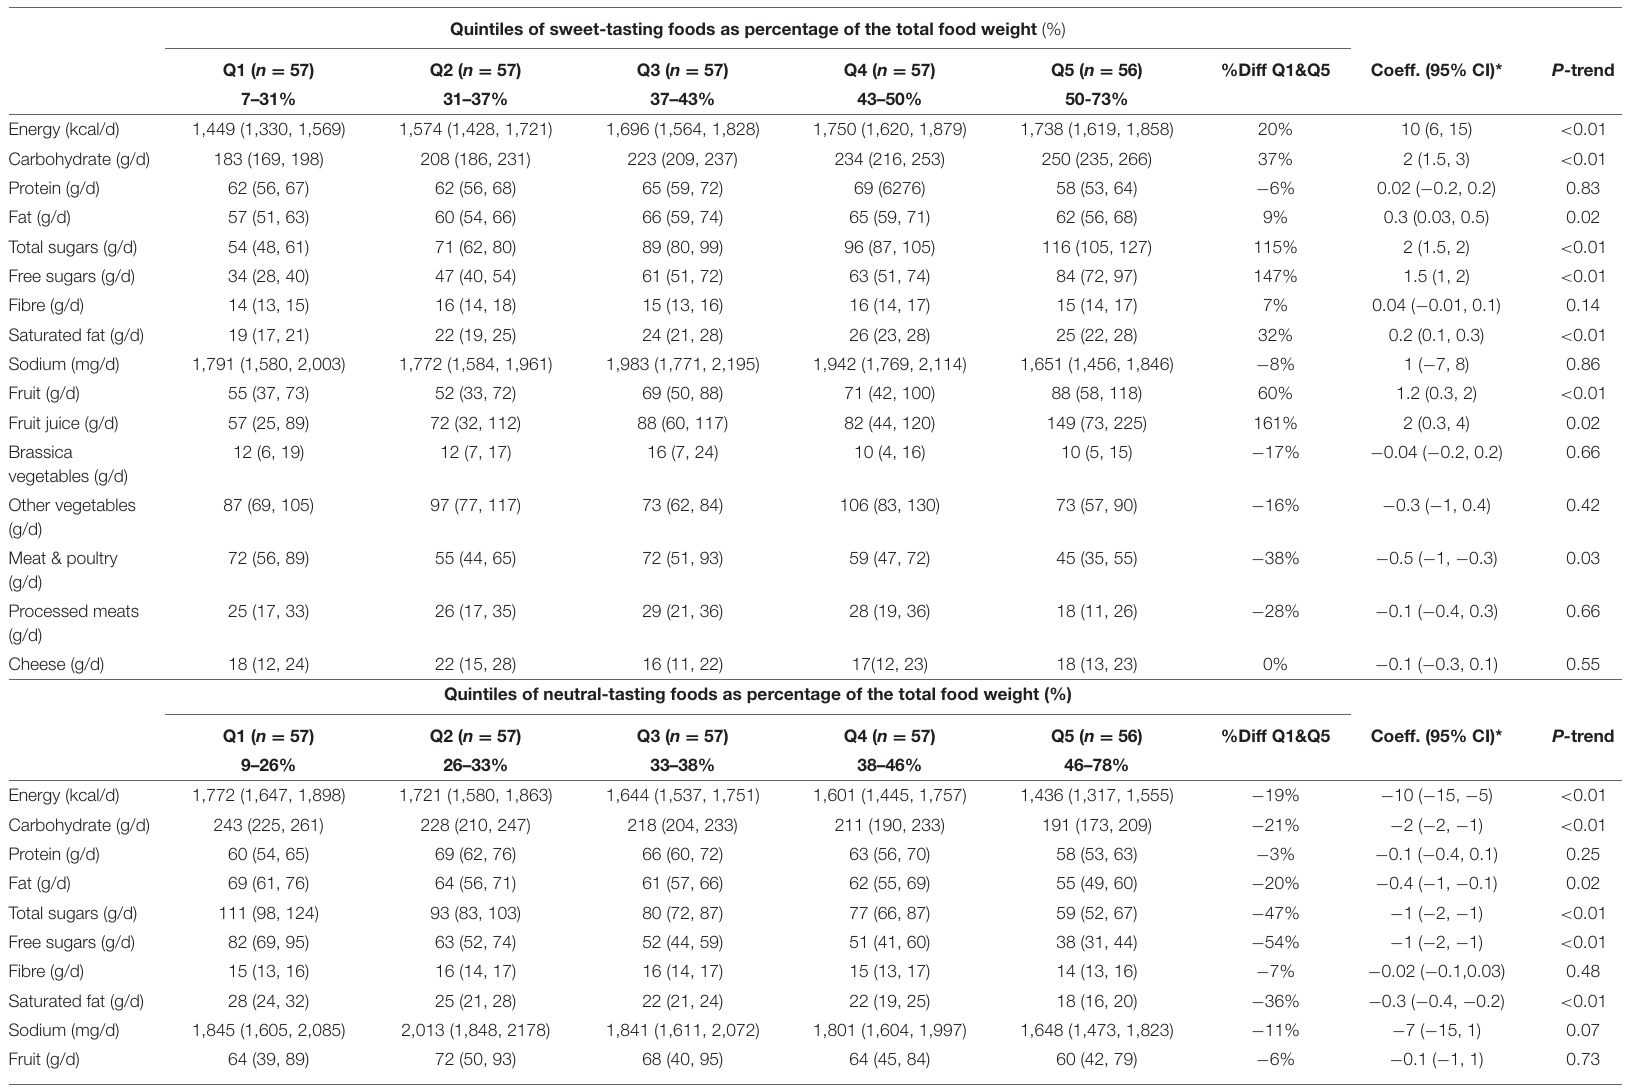
TABLE 2 | Characteristics of adolescents’ dietary intakes by the quintiles (Q) weight of foods consumed as a percentage of the total food weight. Quintiles of sweet-tasting foods as percentage of the total food weight